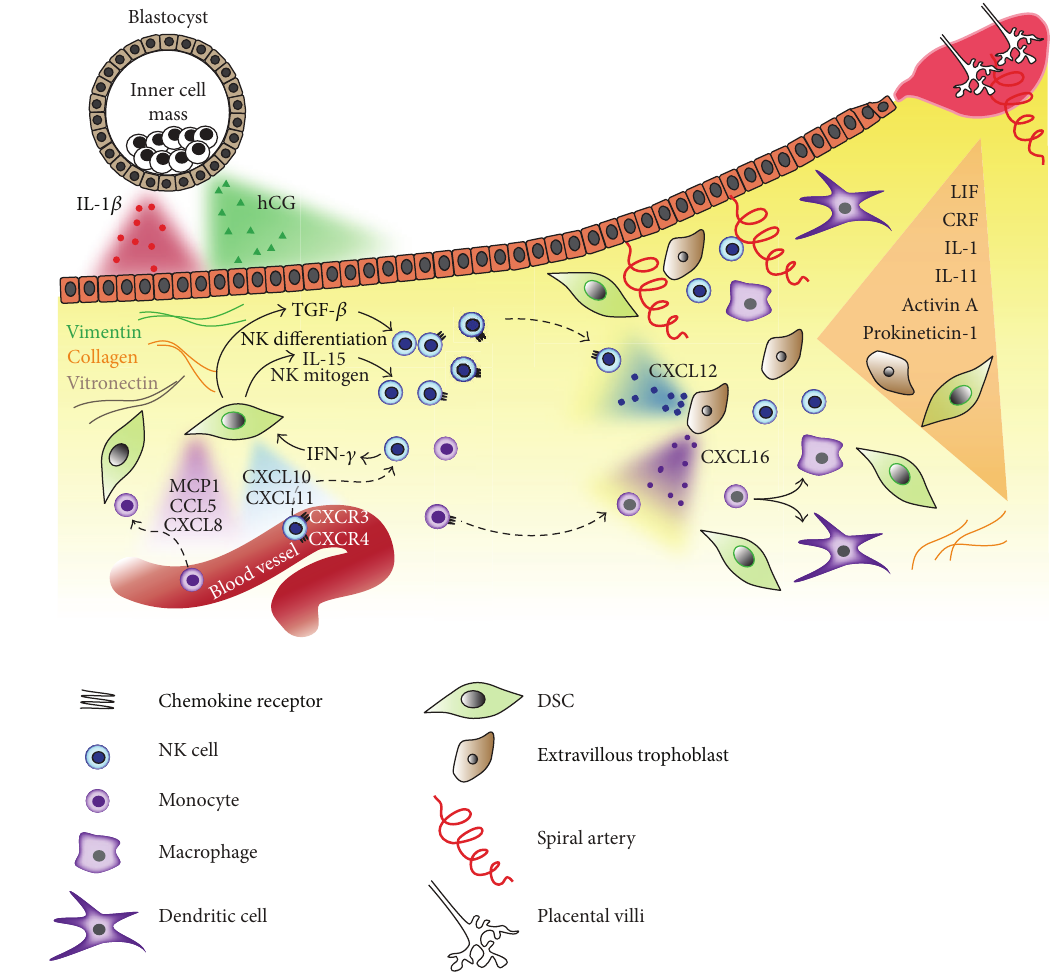
Figure3:Cellrecruitment,invasion,andspatialdistributionandcommunicationoffoetalandmaternalcellsinthepre-andpostimplantation tissue reorganization during placental formation. Decidual transformation of maternal endometrium is induced by ovary hormones and secretory factors released by the embryo. Recruitment of immune cells is performed by chemokines secreted from the differentiating endometrial and trophoblast cells. Immune cell maintenance/proliferation and differentiation are regulated by the cytokines and factors from endometrial and trophoblast cells creating a prompting